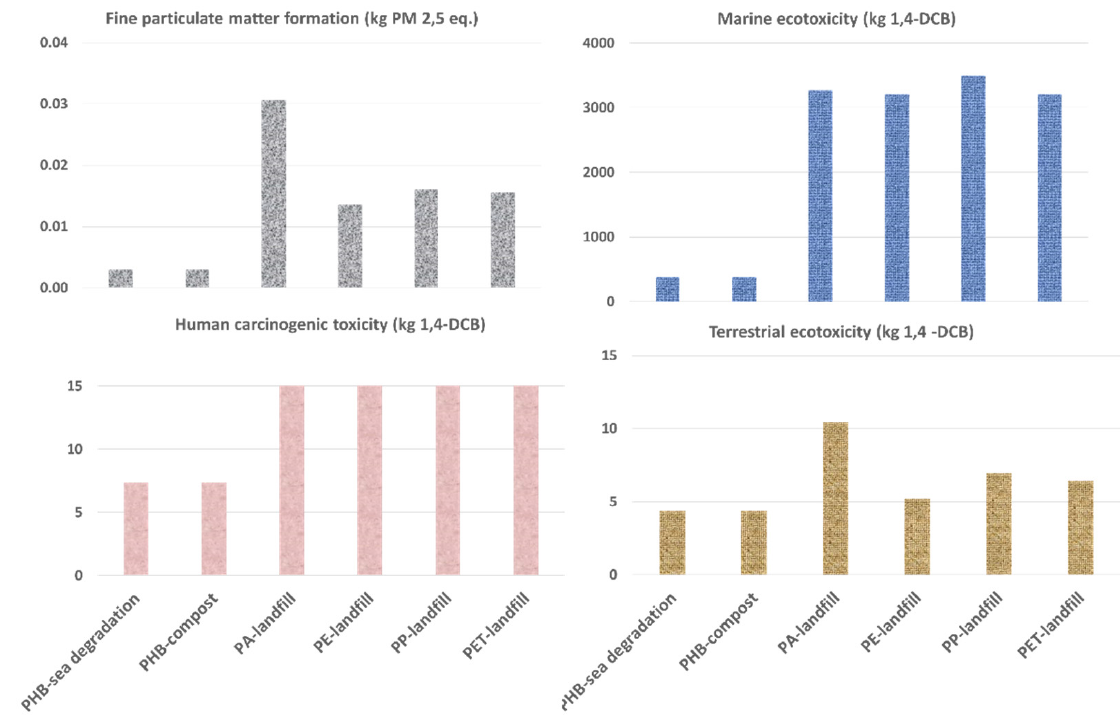
Figure 14. Fine particulate matter formation, marine ecotoxicity, human carcinogenic toxicity and terrestrial acidification categories for cases “a”, “b” and